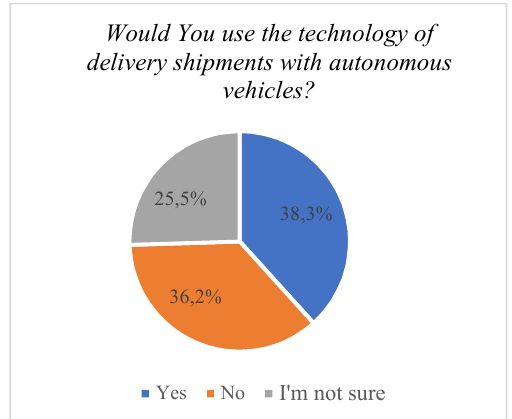
Figure 10. Question Results: Would You use the technology of delivery shipments with